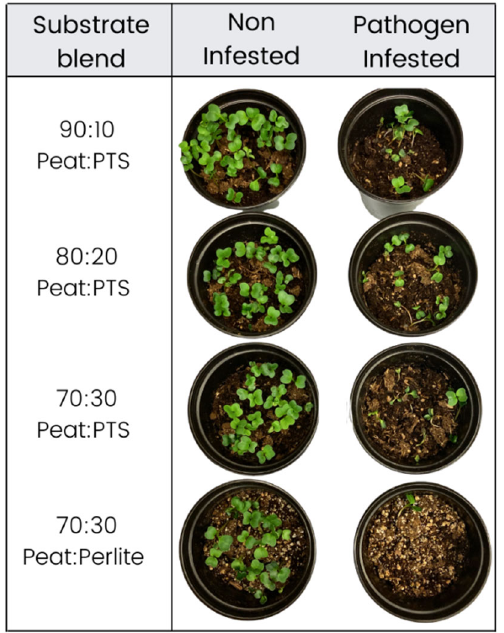
Figure 3. Radish plants grown in non-infested or R. solani -infested peat blended with hammer-milled PTS compared to peat blended with perlite. Images were taken 7 days post ‐ infestation.